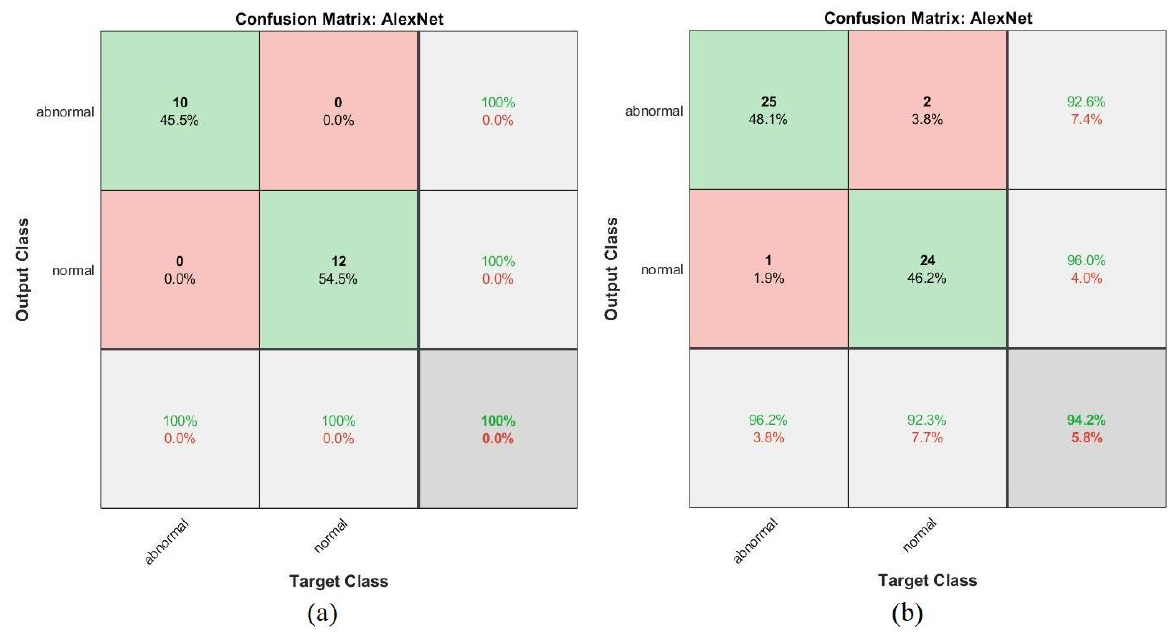
Figure 22. Confusion matrix for the AlexNet model for the ( a ) ALL_IDB1 and ( b ) ALL_IDB2 datasets.